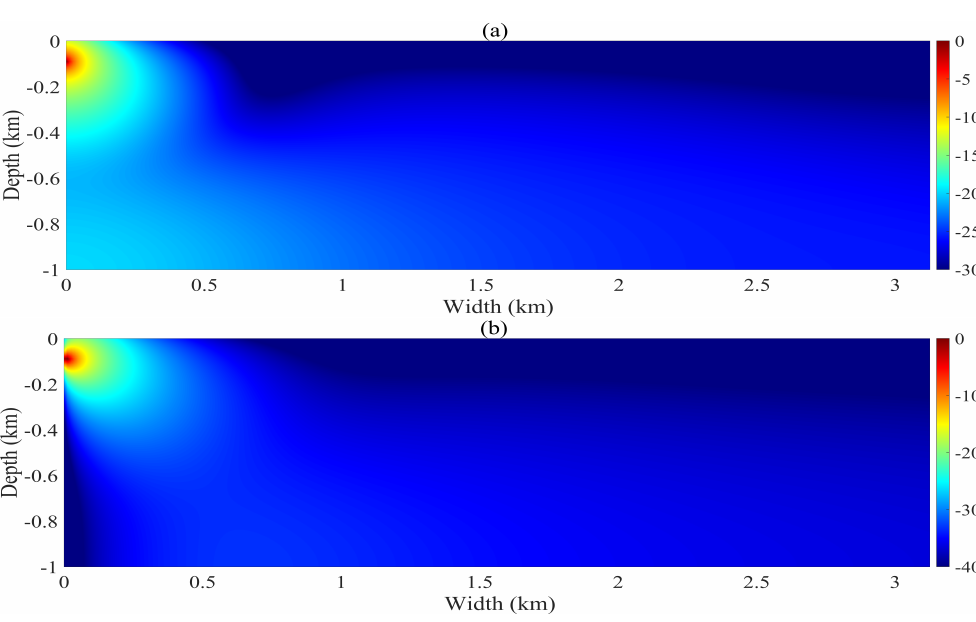
Figure 2. Acoustic pressure and flow velocity distributions calculated using SEM. ( a ) Pressure wave distribution. ( b ) Radial component of the velocity